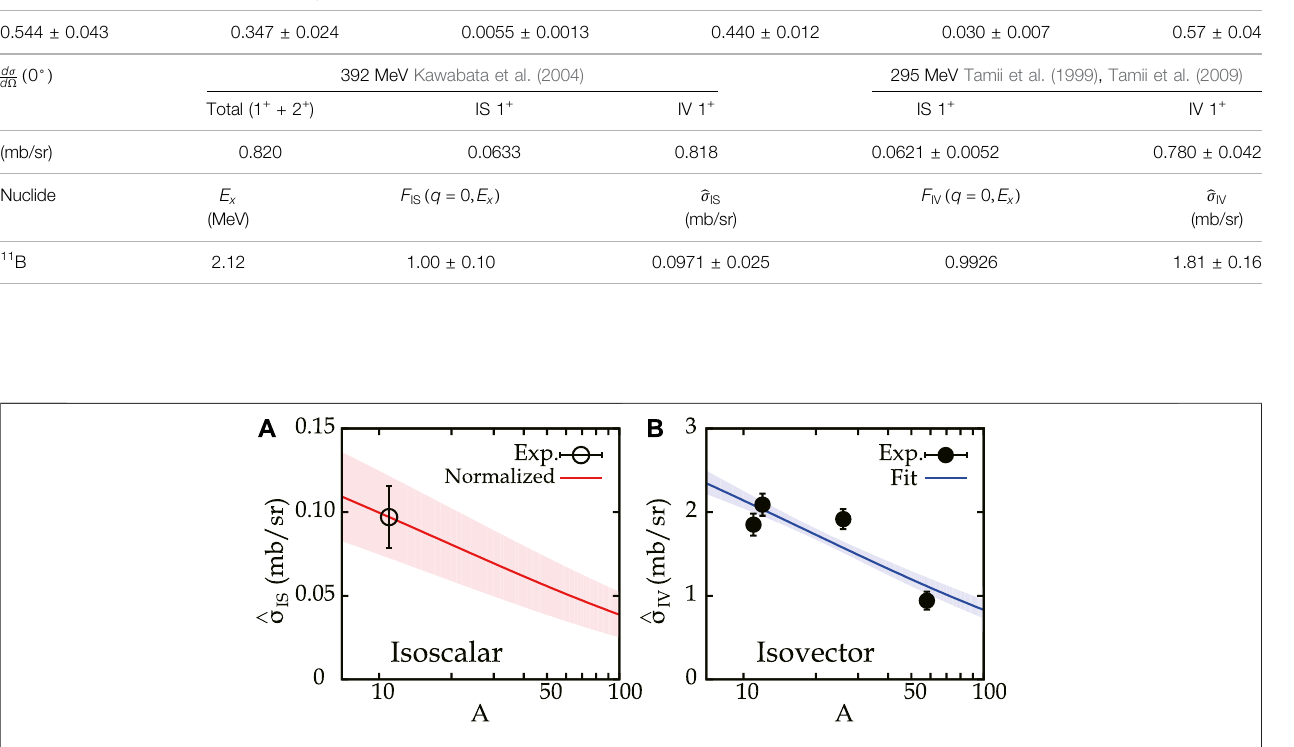
FIGURE4| Empirically determinedIS (left) andIV (right) UCSs.Themassdependenceofthedatawere fi twiththefunctionalformof Eq.33 asshownbythesolid lines in the IV panel. The band shows the uncertainty of one sigma. The IS slope parameter x IS is taken to be the same as x IV . The fi gures were adapted from Matsubara et al. (2015).